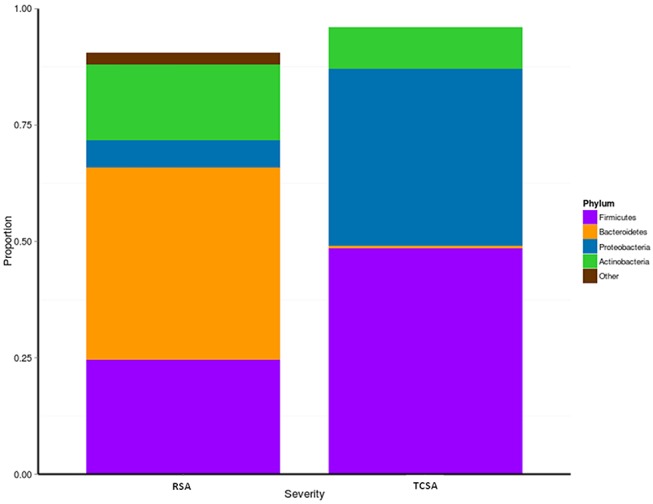
We assessed microbial composition by comparing the relative abundances of taxa at phylum level. When considering the communities at the phylum level, differences between RSA and TCSA microbiota were clearly evident. Bacteroidetes represented over 33% of all bacteria in RSA and where basically absent (<2%) in TCSA. Similarly, Proteobacteria accounted for nearly 40% of all bacteria in TCSA and for <5% in RSA. Conversely, Firmicutes and Actinobacteria were present both in RSA and TCSA without statistically significant differences.